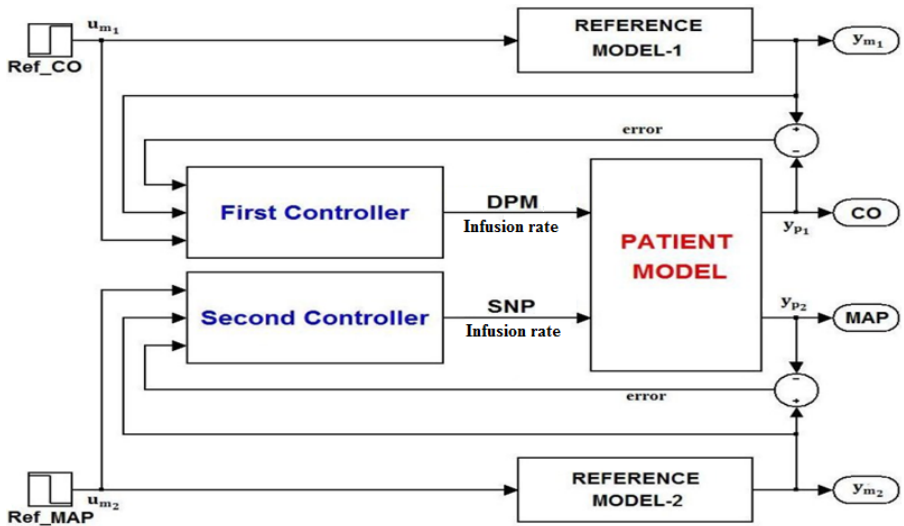
Figure 3: Simulink block diagram of the patient model with the